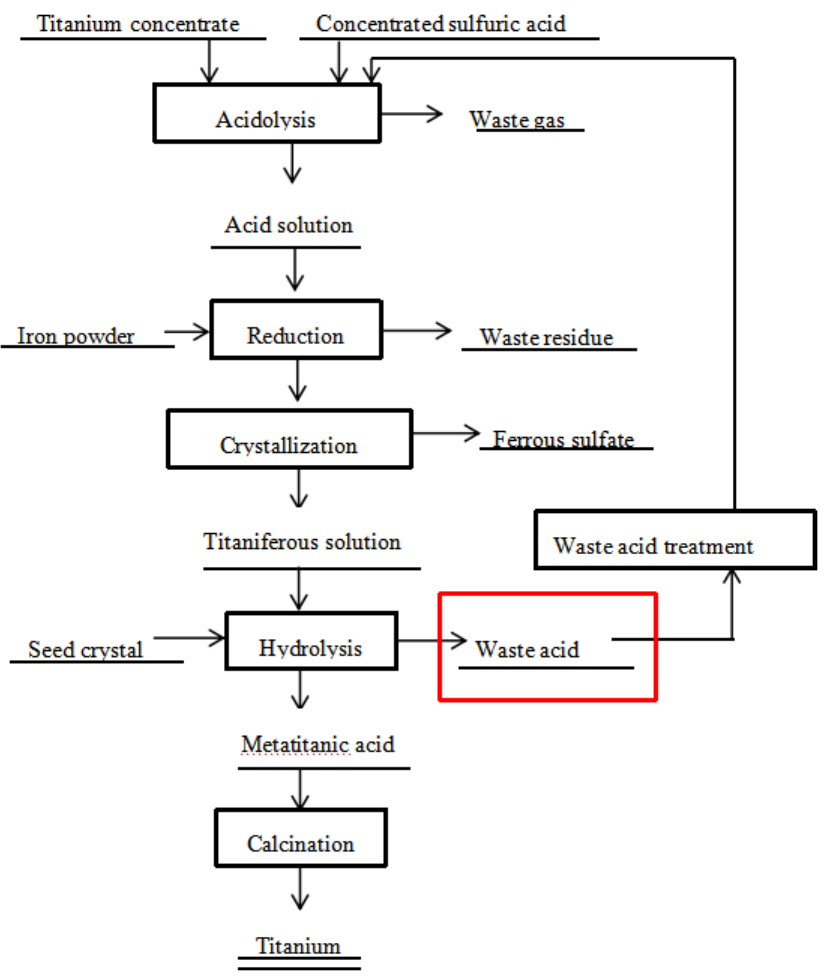
Figure 1. Technological route of titanium dioxide production by sulfuric acid decomposition.